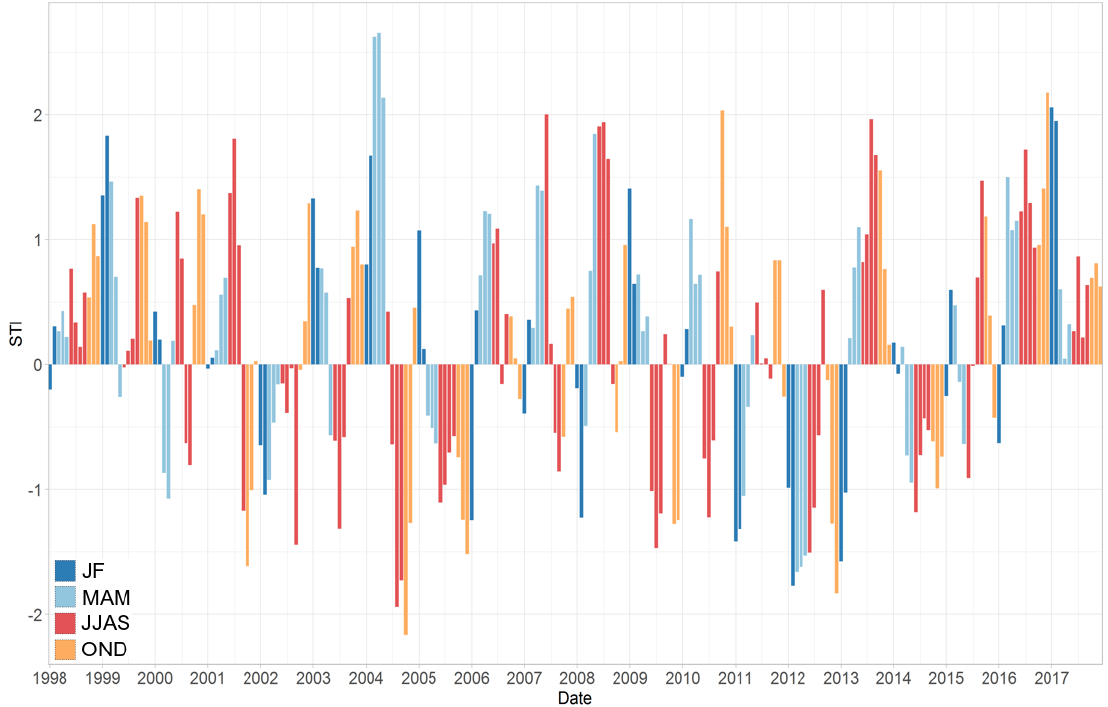
Figure 8. STI from 1998 to 2017 for the monthly temperature anomaly, color-coded for the seasonal distribution: January and February (JF) in dark blue, March to May (MAM) in light blue, June to September (JJAS) in red, and October to December (OND) in